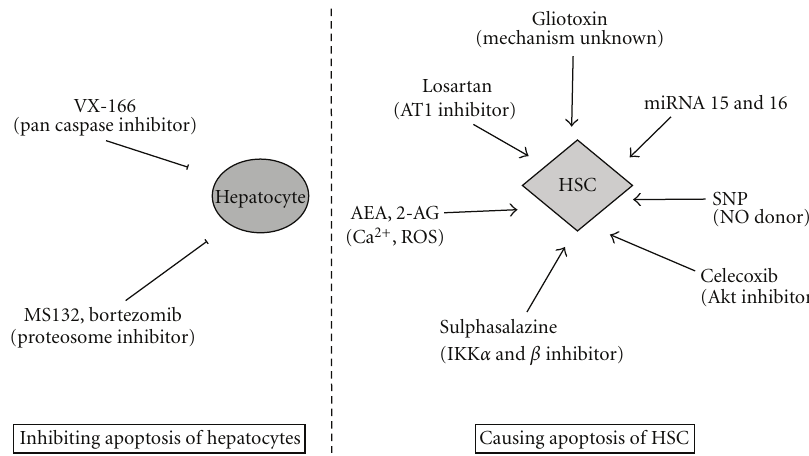
Figure 1: Mechanisms for targeting apoptosis to treat liver disease and cause fibrosis